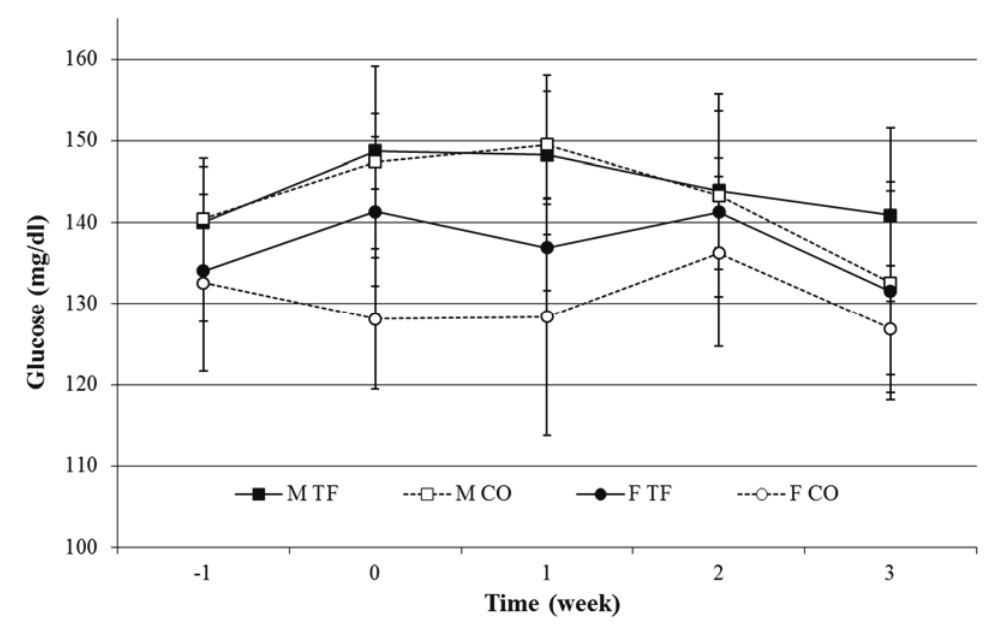
Figure 5. Plasma glucose levels (mg/dL) in male (squares) and female (circles), transferred (black symbols-solid line) and control (white symbols-dotted line) rats, one week before, on day of transfer and one, two and three weeks after transfer ( n =